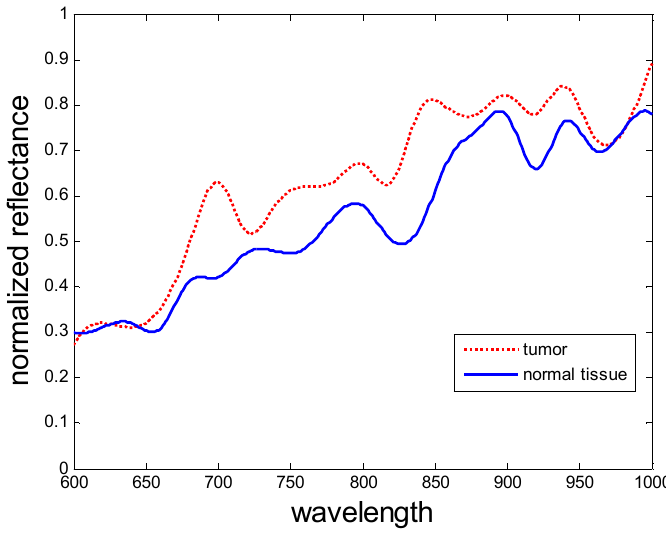
Figure 5. Reflectance spectra. Tumor pixels are shown in red and normal pixels are shown in blue.